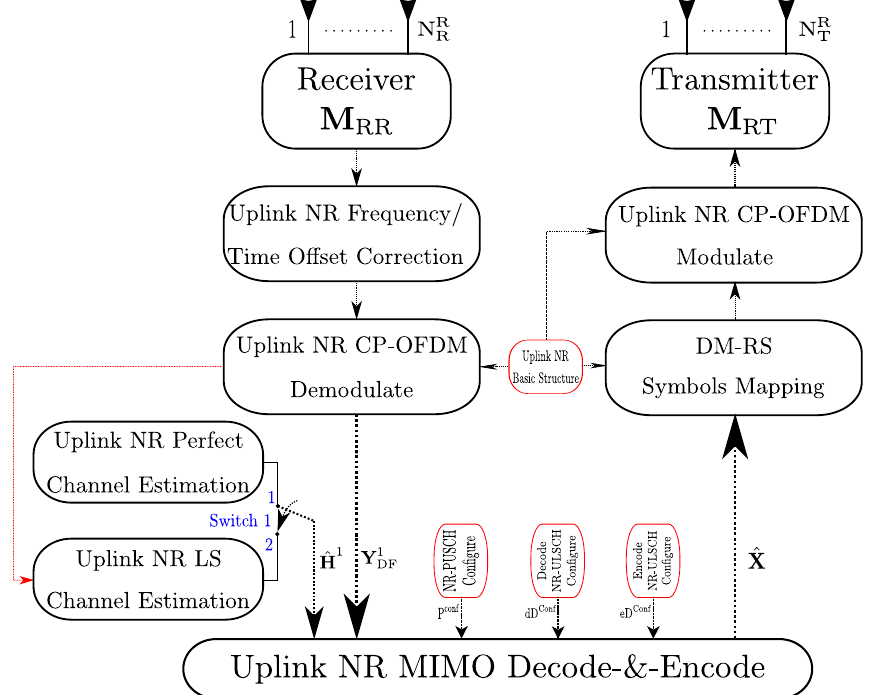
Figure 6. Decode-and-forward (D&F) uplink mmWave MIMO new radio relay node process- ing